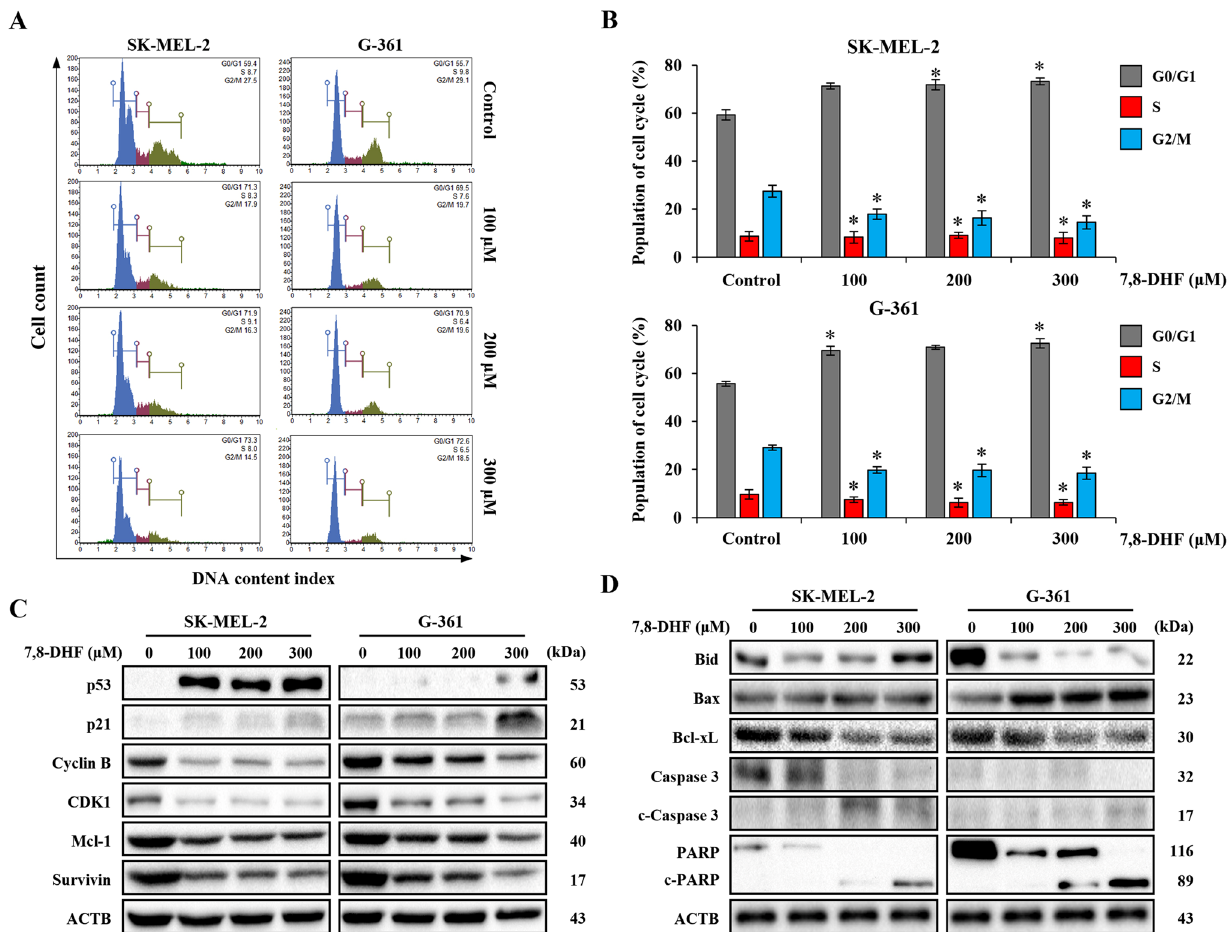
Fig. 3 Anti-proliferative and apoptotic effects induced by 7,8-DHF in malignant melanoma cells. A SK-MEL-2 (1.0 × 10 5 cells/well) and G-361 cells (1.0 × 10 5 cells/well) were incubated without 7,8-DHF (control group) or with 7,8-DHF (100, 200, and 300 µM for 24 h). Cells were then washed with DPBS, fixed in 70% ethanol overnight, stained with Muse ™ Cell-Cycle reagent, and finally analyzed for DNA content using a Muse ™ Cell analyzer. B The results of cell cycle population in SK-MEL-2 and G-361 cells were quantified. Data represented the mean ± SD ( n = 3, * p < 0.05). C SK-MEL-2 and G-361 cells were treated with different concentrations of 7,8-DHF (100, 200, and 300 µM for 24 h). Whole cells extracts were prepared, separated on SDS-PAGE, and transferred onto blotting membranes. Western blot analysis was performed using p53, p21, Cyclin B, CDK1, MCL-1, and Survivin antibodies. D SK-MEL-2 and G-361 cells were treated with 7,8-DHF (100, 200, and 300 µM for 24 h). The lysate samples were subjected to western blot analysis with BID, BAX, BCL- L, Caspase 3 (CASP3), cleaved-CASP3, poly (ADP- X ribose) polymerase (PARP), and cleaved-PARP antibodies. β-actin was used as a loading control. The results shown in C , D were